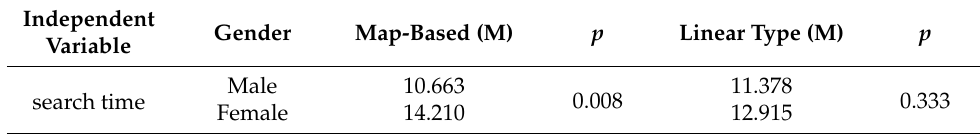
Table 3. Search Time of Different Route Map